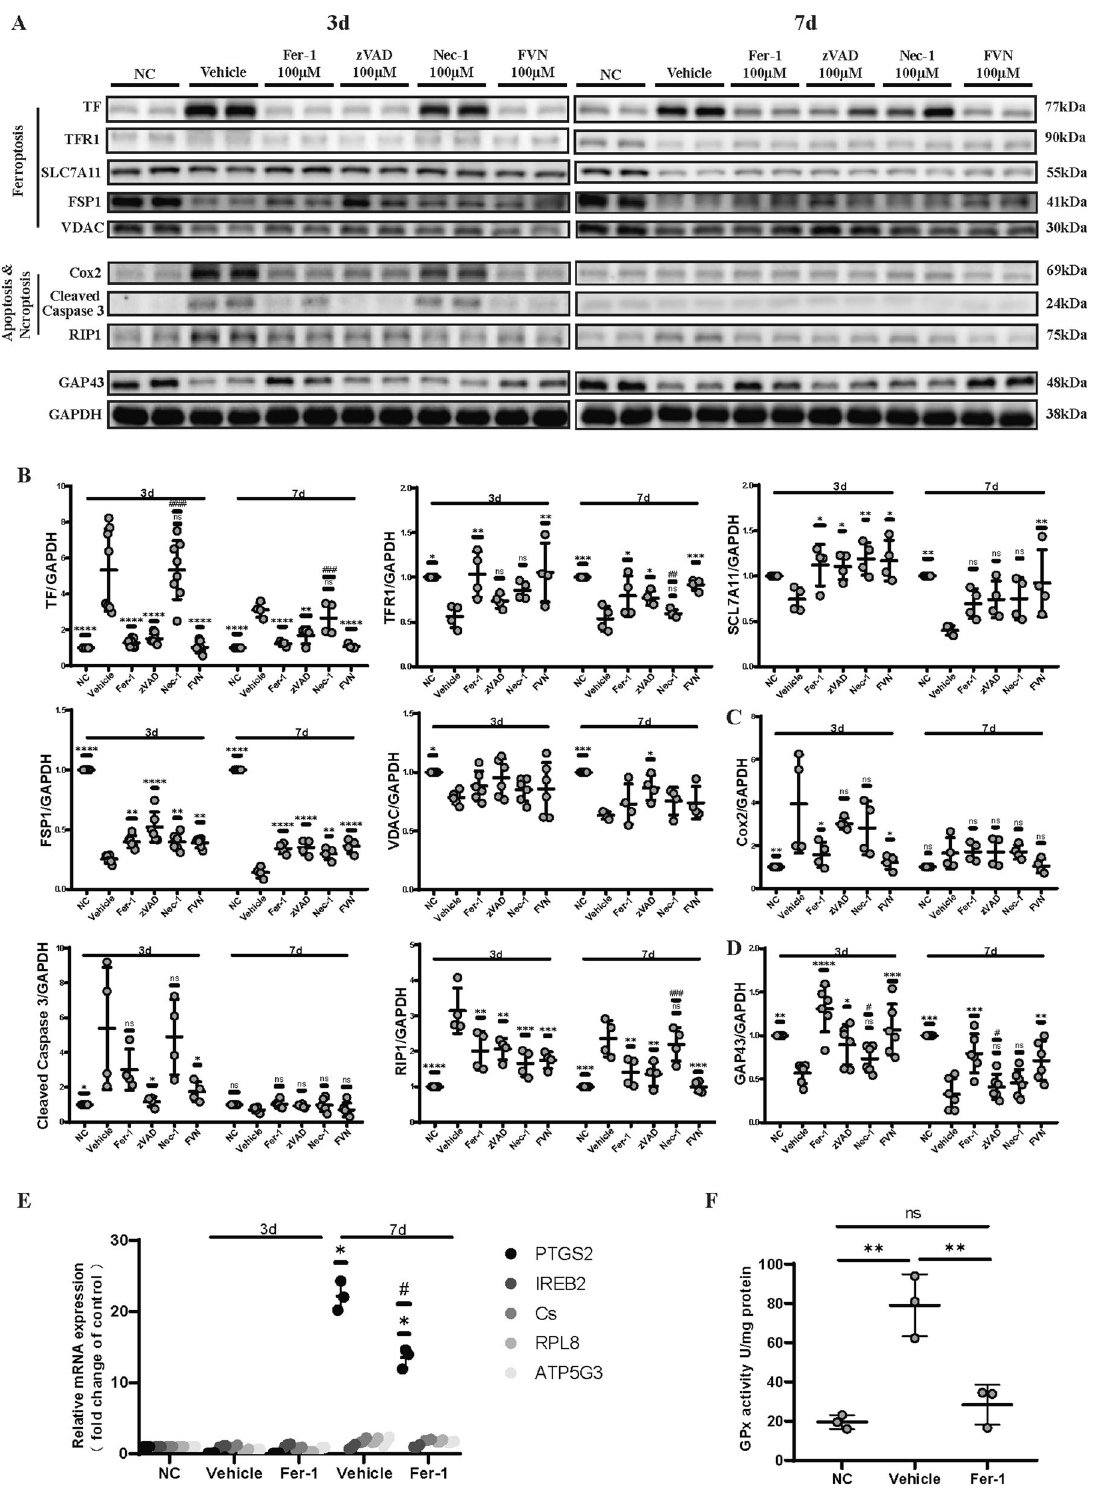
Fig. 4 In situ administration of Fer-1, zVAD, Nec-1, and their combination alters the expression of death pathway- and neurogenesis- related proteins. A Western blot bands of the indicated proteins in sham or IR-injured retina 3 and 7 d after each treatment and ( B , C , D ) quantitative analysis of the protein expression levels of ferroptotic markers ( B : TF, TFR1, SLC7A11, FSP1, VDAC), apoptotic and necroptotic markers ( C : Cox2, cleaved Caspase 3, RIP1), neurogenesis-related marker ( D : GAP43), and GAPDH ( n = 4 – 6). E Expression of the genes involved in ferroptosis was examined in sham or IR-injured retina by qRT-PCR at 3 and 7 d post-vehicle (DMSO) or post-Fer-1 treatment ( n = 3). Data in E are represented as mean ± SD; * p < 0.05 versus NC; # p < 0.05 versus vehicle; one-way ANOVA with Bonferroni post hoc analysis. F GPx activity of sham or IR-injured retina with vehicle (DMSO) or Fer-1 treatment was measured with a GPx assay kit at 3 d post-IR ( n = 3). Data in ( B – D , F ) are represented as mean ± SD; * p < 0.05, ** p < 0.01, *** p < 0.001, **** p < 0.0001 versus vehicle; # p < 0.05, ## p < 0.01, ### p < 0.001, #### p < 0.0001 versus FVN; one-way ANOVA with Bonferroni post hoc analysis. NC normal control, IR ischemia reperfusion, FVN combination of Fer-1, zVAD, and Nec-1. Cell Death and Disease (2022)